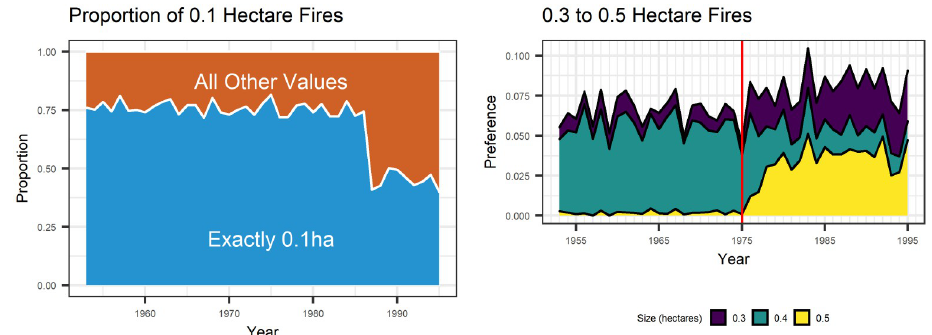
Fig 2. Evidence of rounding and unit change. Prior to 1985, 75% of all fires were recorded as being exactly 0.1ha. The decrease in proportion coincides with the advent of fires recorded as 0ha. In 1975, Canada switched to the metric system. This means that fires were approximated as being 0.5ha rather tham 0.4ha (1 acre). Note that the proportion of 0.1ha fires did not change since 1/10th of a hectare and 1/4th of an acre are both coarsening